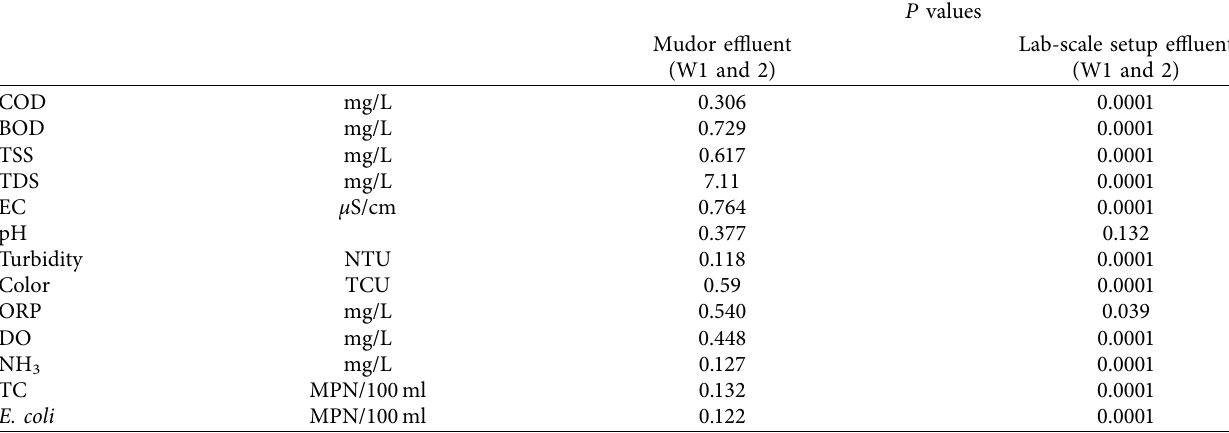
Table 5: P values for analyzed Mudor and lab-scale setup efuent for weeks 1 and 2.